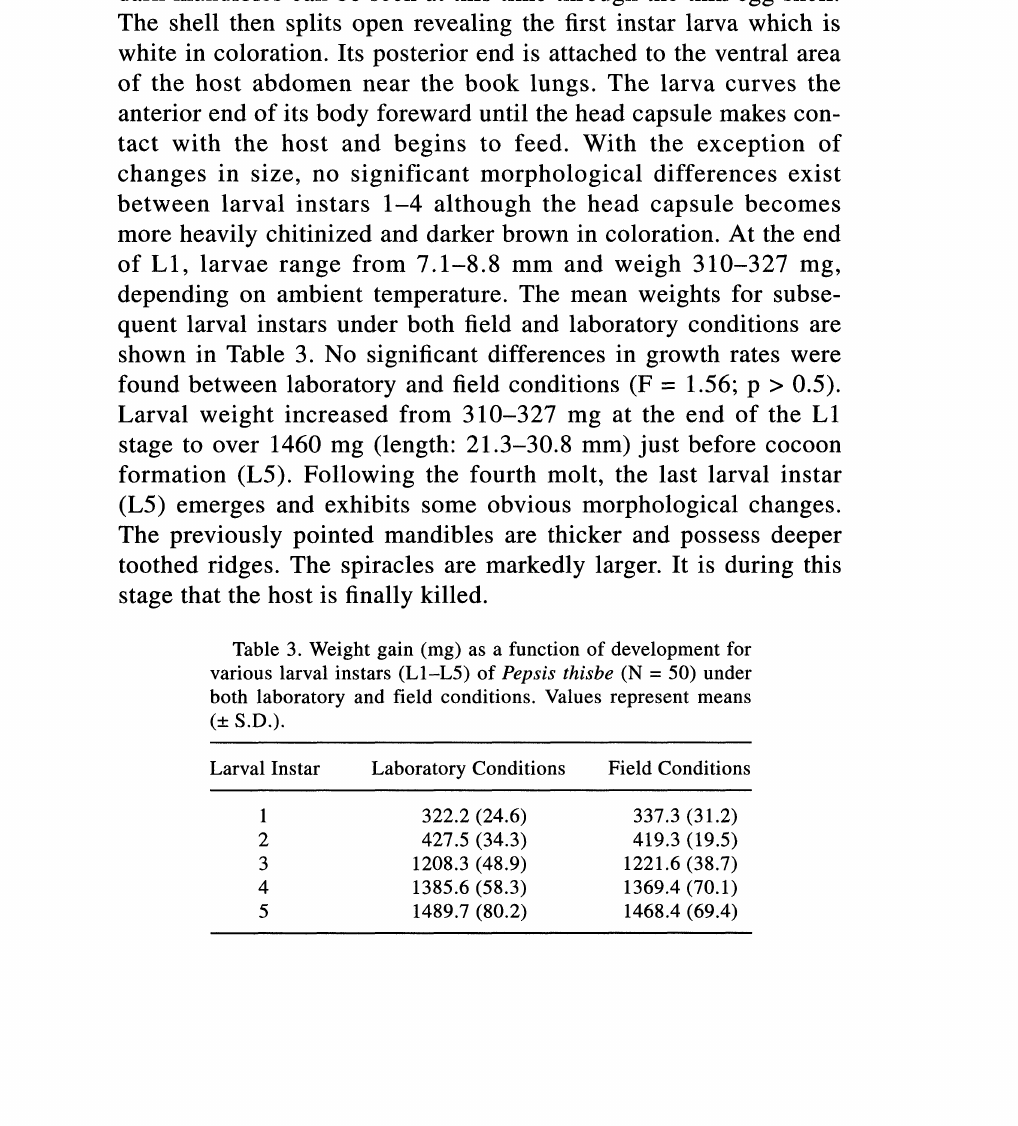
Table 3. Weight gain (mg) as a function of development for various larval instars (L1-L5) of Pepsis thisbe (N 50) under both laboratory and field conditions. Values represent means (+_